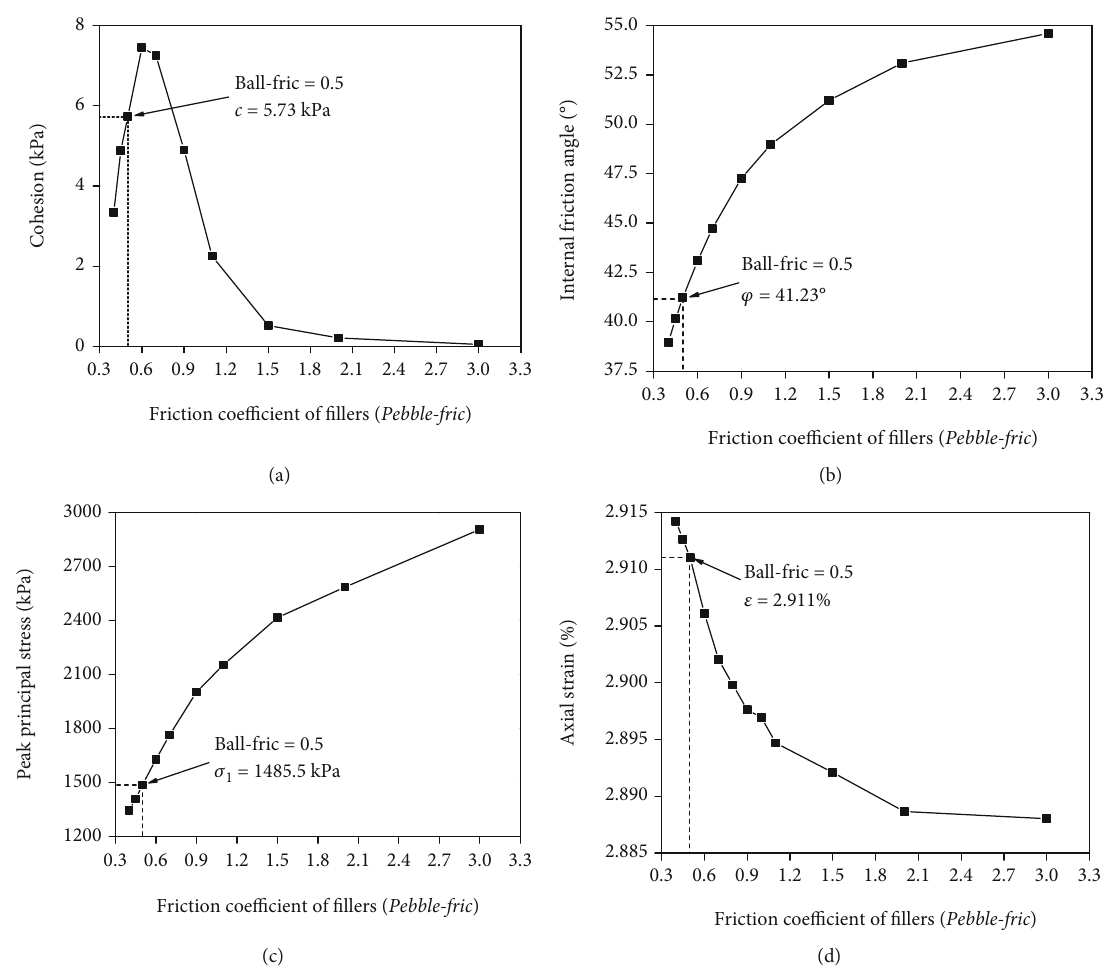
Figure 8: In fl uence of pebble-fric on macromechanical parameters: (a) cohesion, (b) internal friction angle, (c) peak principal stress, and (d) axial